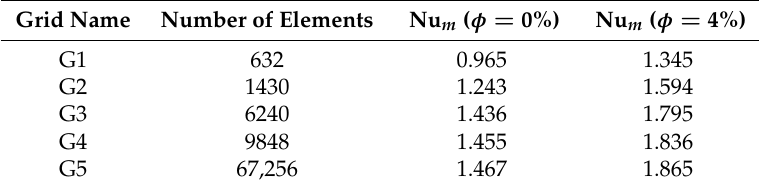
Table 3. Grid independence test with spherical particles at two different solid particle volume fractions.